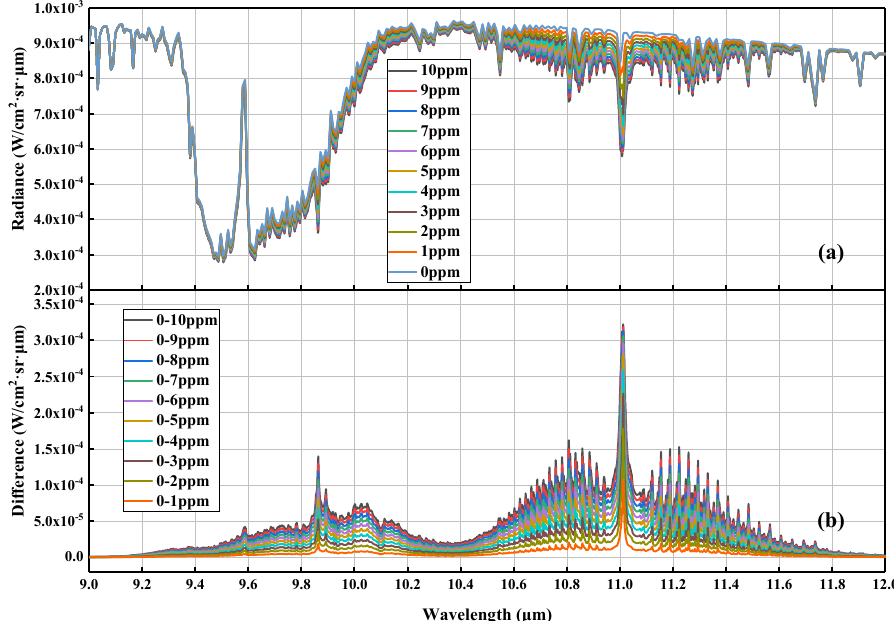
Figure 6. ( a ) The at-detector radiance of 9.0–12.0 μ m for 1,3-butadiene concentrations (0–10 ppm), ( b ) the difference between the radiance of 0 ppm 1,3-butadiene, and the other 1,3-butadiene concen- trations (1–10 ppm).